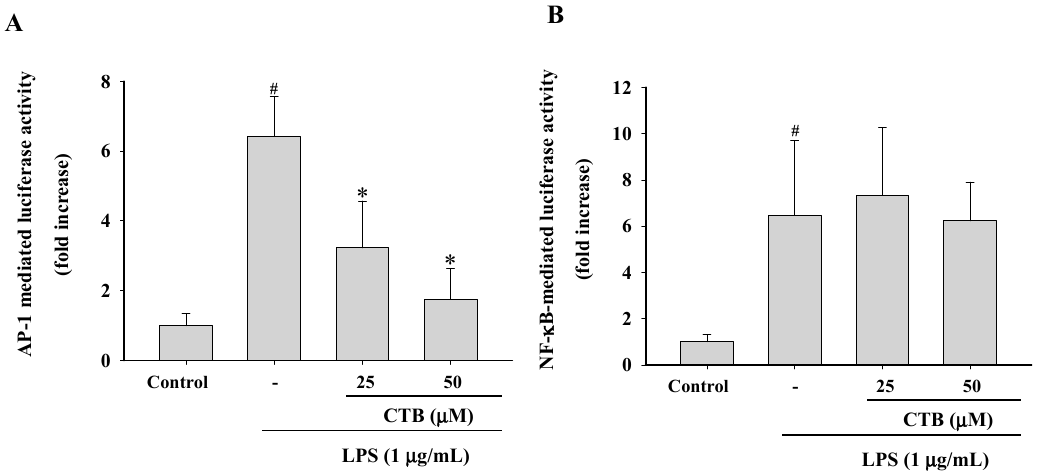
Figure 4. Effects of CTB on transcription factor translocation. RAW264.7 cells co-transfected with plasmids containing AP-1-luc ( A ) or NF- κ B ( B ) luciferase constructs were treated with CTB in the presence or absence of LPS. Luciferase activity was determined by luminometry. Values are the mean ± SD of triplicate experiments. * p < 0.05 compared to LPS treatment alone; # p < 0.05 compared to control group.